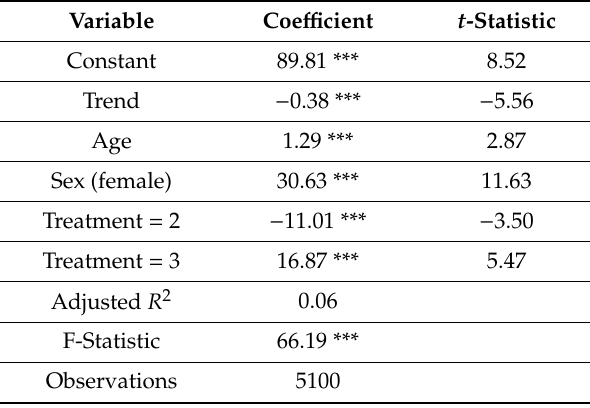
Table 3. Round trend of tax payments (combined